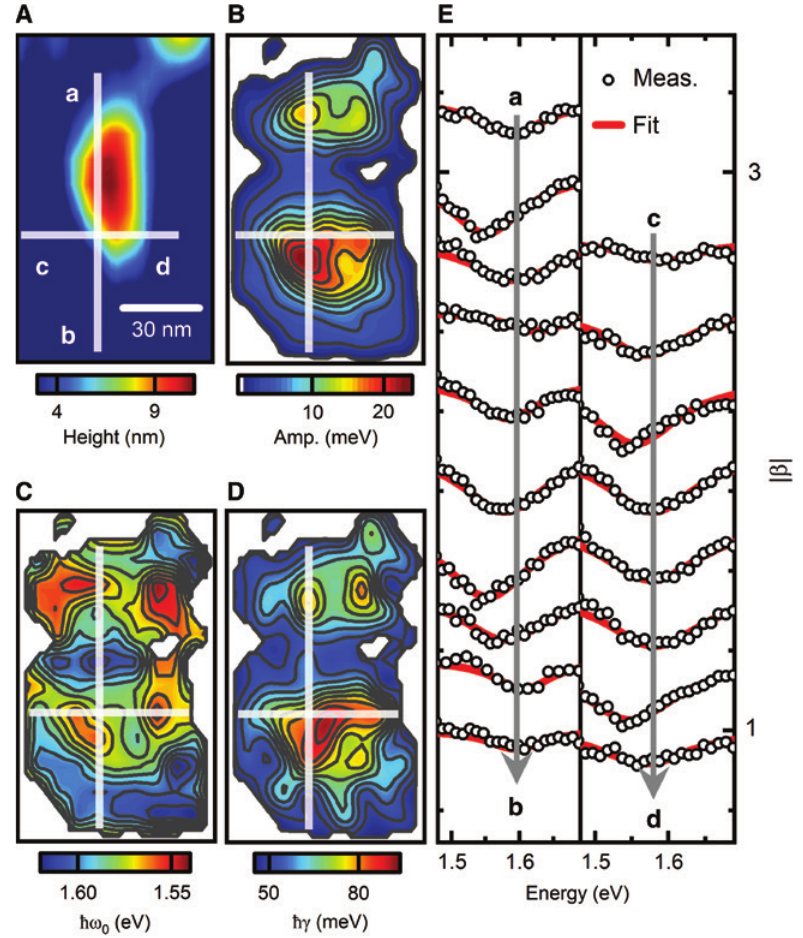
Figure 4: Line-shape analysis of PNSI spectra near a single gold nanorod. (A) AFM topography image of the nanorod. (B–D) Parameter maps of the normalized amplitude (B), resonance energy (C), and line width (D) of the LSP resonance extracted from the PNSI spectra. At each pixel of the scan, a PNSI spectrum is reconstructed from a referenced SI and fitted to a Lorentzian line shape. The maps of the resonance amplitude (B) and the line width (D) show the two-lobed intensity profile of the longitudinal nanorod LSP mode, while the resonance energy (C) shows a more complicated pattern with enhanced red shifts near the rim of the nanorod. (E) PNSI spectra (open circles) taken along the lines a–b and c–d in panel (A), emphasizing the red shift of the LSP resonance near the rim of the nanorod. The solid red lines are fits to a Lorentzian oscillator